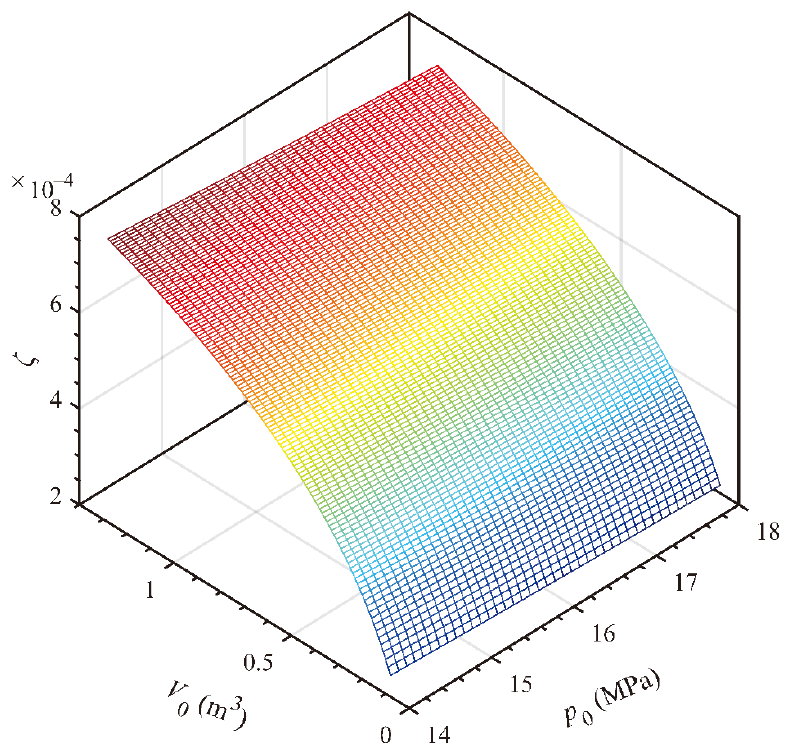
Figure 10. Effects of the high-pressure accumulator initial pressure and volume, p 0 and V 0 , on the damping ratio, ζ .